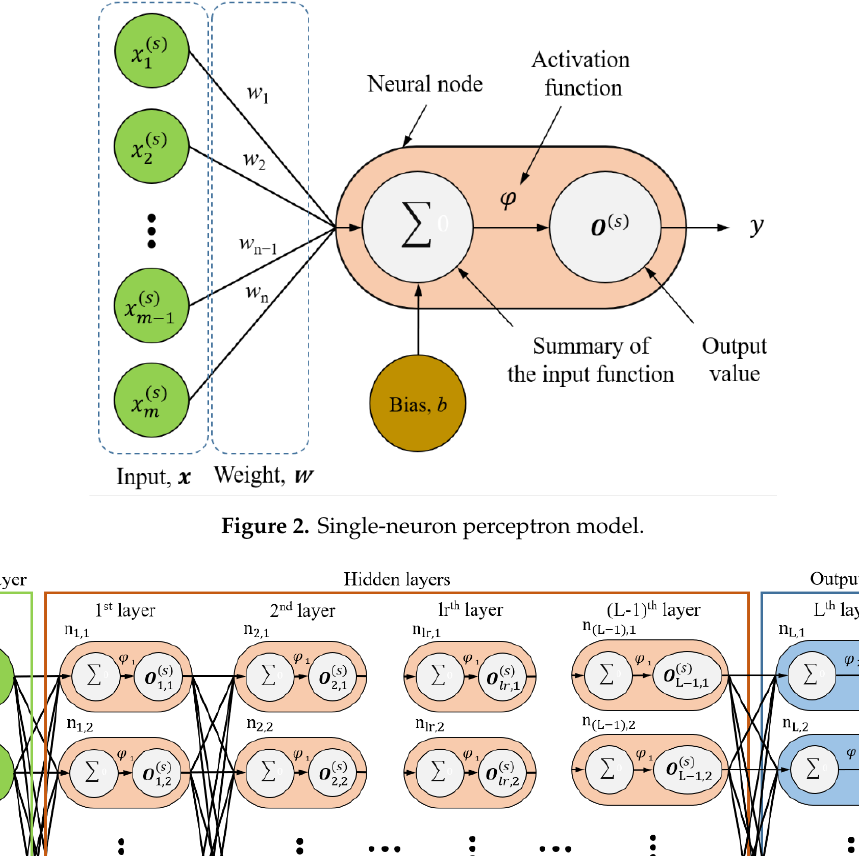
Figure 2. Single-neuron perceptron model.